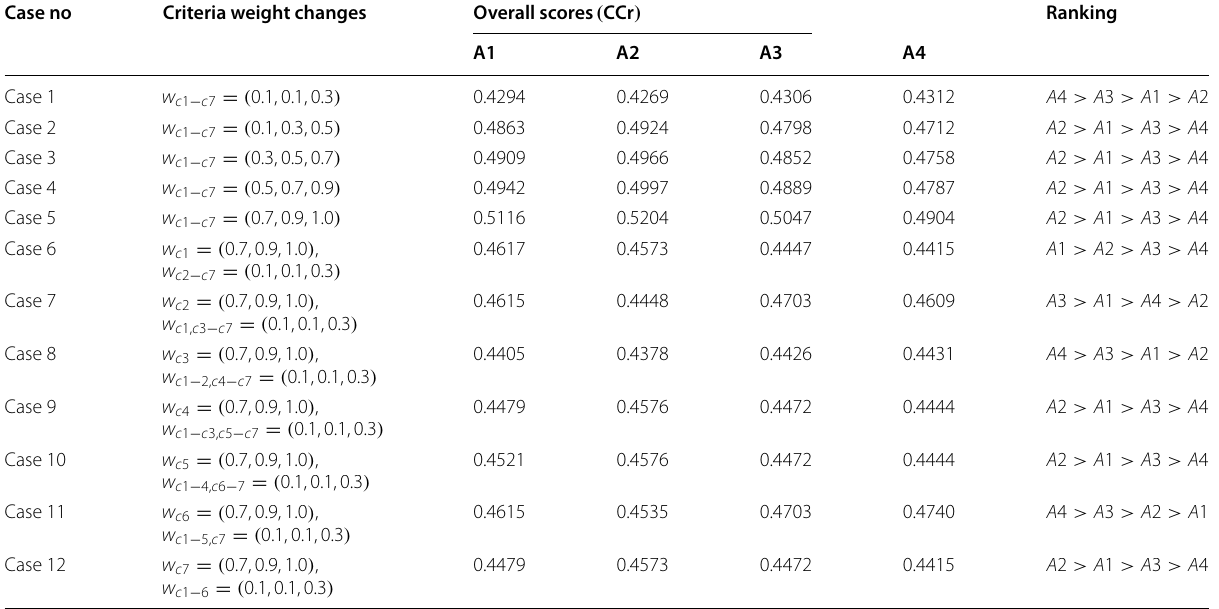
Table 16 Changes to the criteria weights for sensitivity